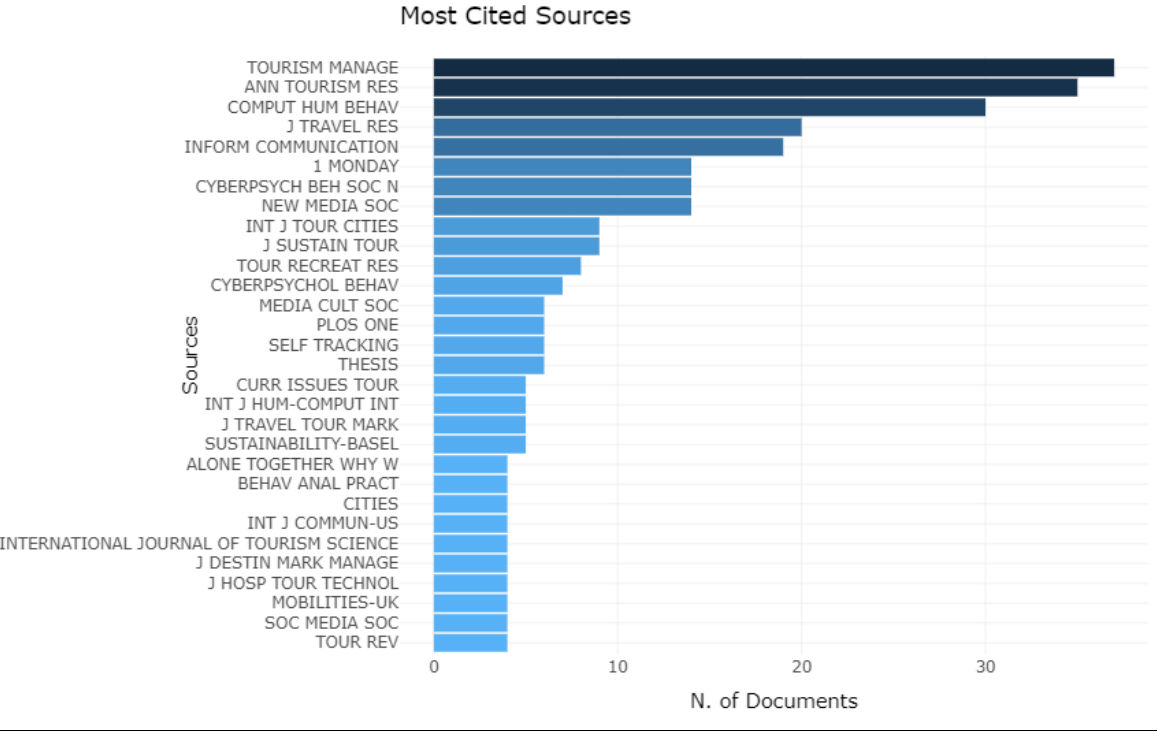
Figure 3. Most cited sources Table 4. Main Relevant